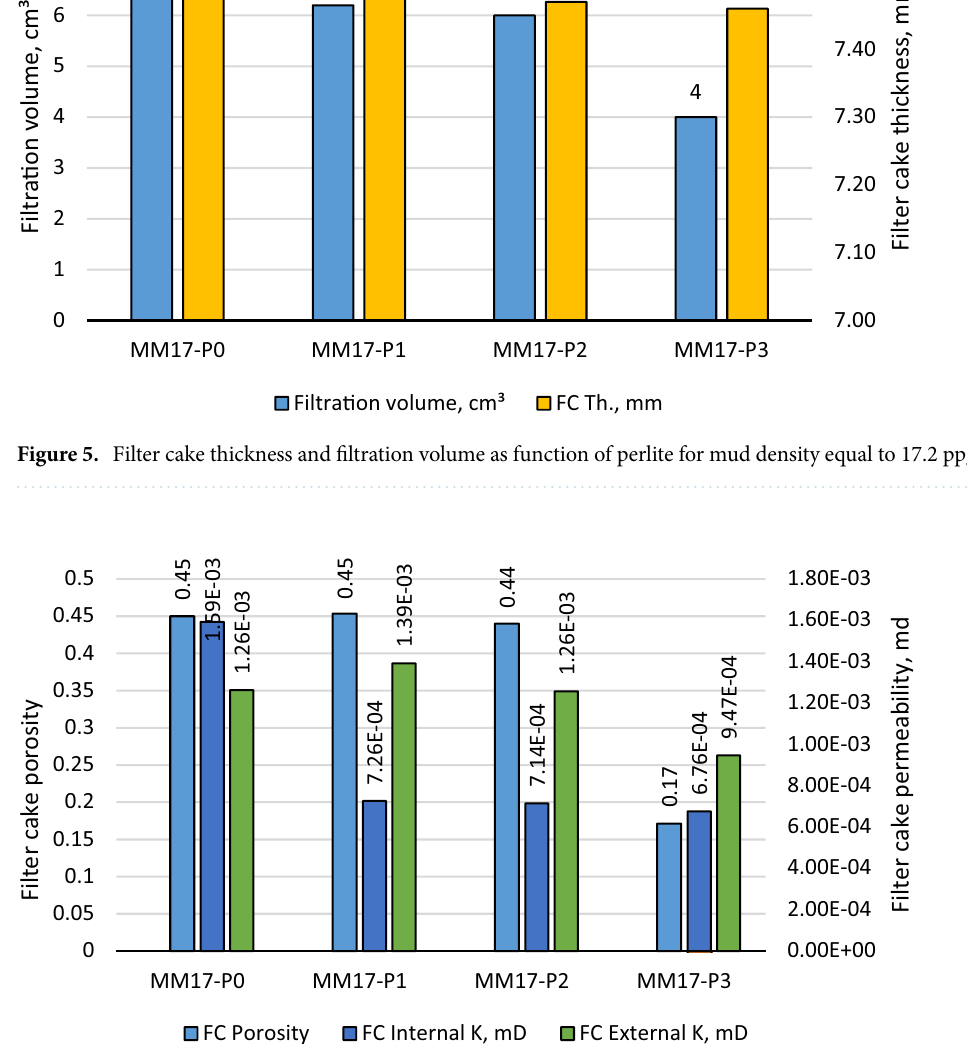
Figure 6. Porosity and the layer permeability of filter cake as function of perlite for mud density equal to 17.2